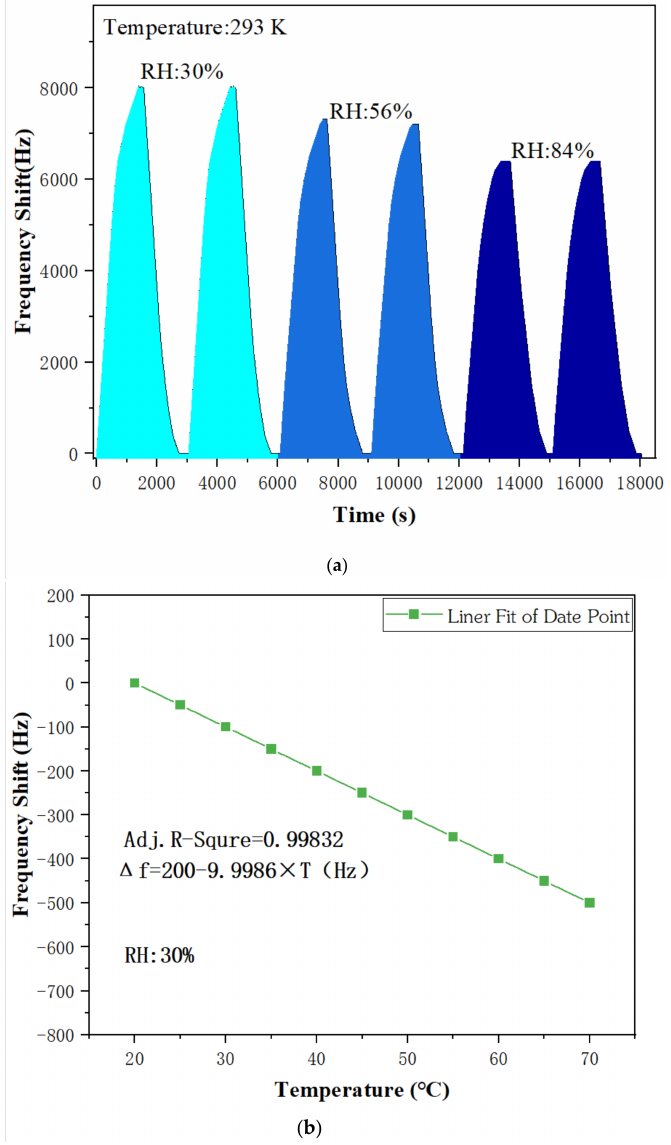
Figure 11. ( a ) Response–recovery curve of PAA SAW sensors to 20 ppm ammonia gas at room temperature of 293 K and different RH values; ( b ) the relationship between the resonant frequency shift of the PAA SAW sensor and